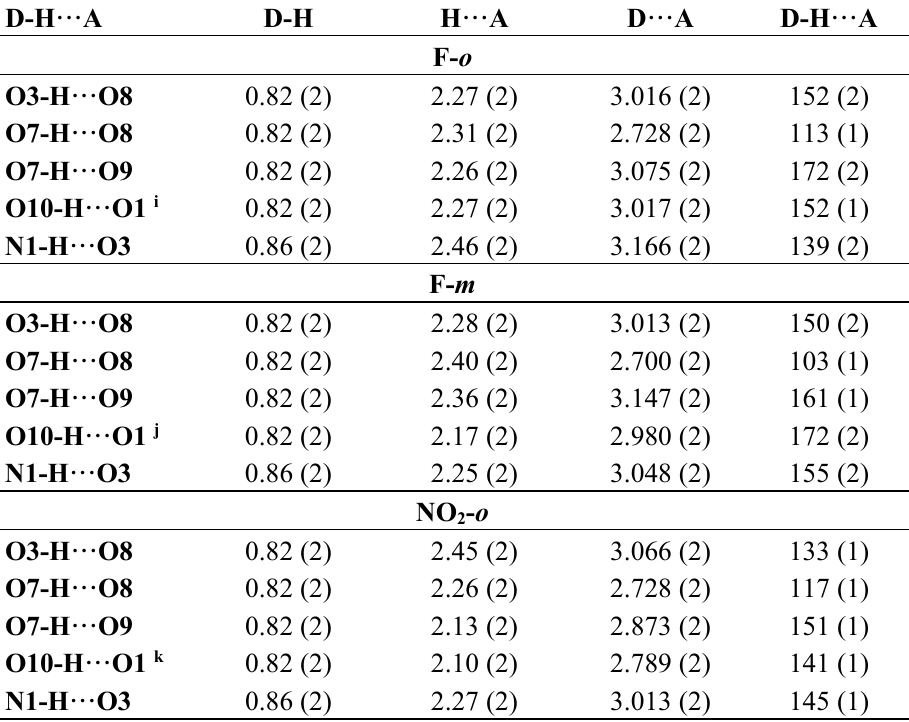
Table 2. Hydrogen-bond geometry (Å, °) in the crystal structures of SAL benzyl amides ( F- o , F- m and NO - o 2